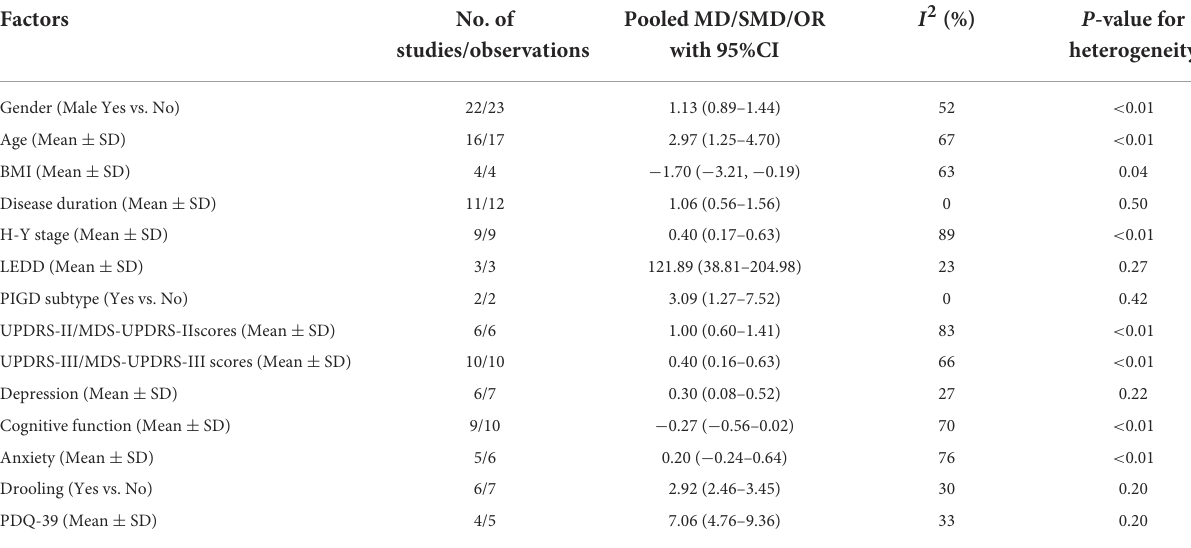
TABLE 3 Meta-analyses of associated factors of dysphagia in PD based on random-effect analysis. Factors No. of